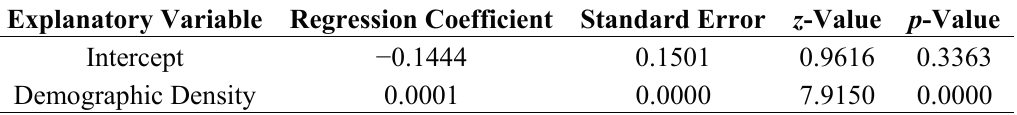
Table 5. Spatial autocorrelation (SAR) lag model: Rome, total VRU traffic